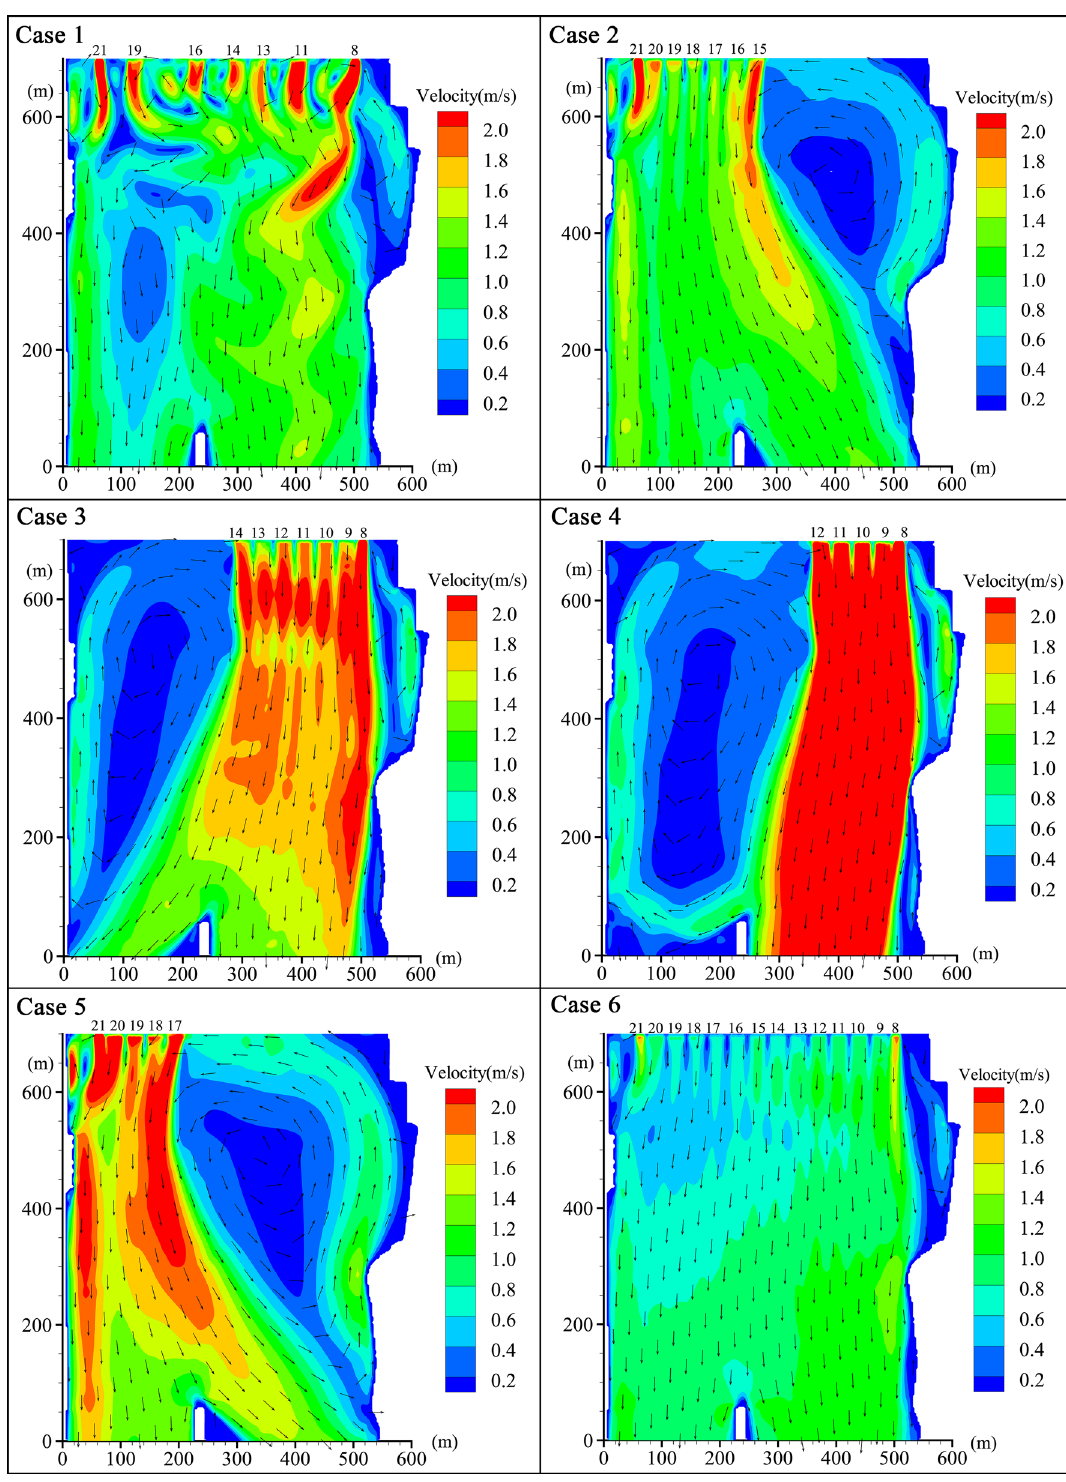
Figure 3. Flow field of the spawning ground in different opening modes with identical discharge, where the numbers at the top of each picture are the numbers of units to open, and the arrows indicate the direction of the water flow. Maps generated in Tecplot360 EX 2020 R1 (https:// www. tecpl ot. com/ produ cts/ tecpl ot-